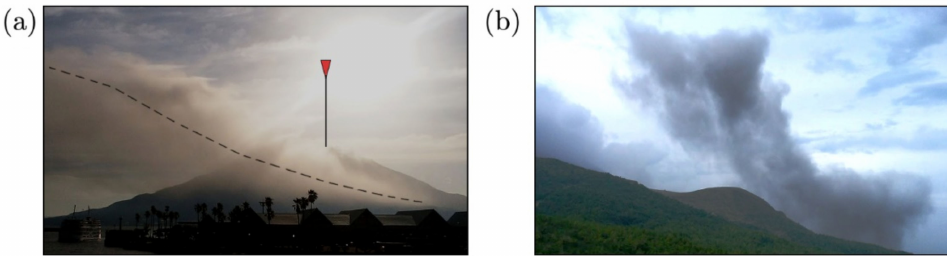
Figure 2. Influence of: ( a ) shear, and ( b ) orographic effects on the dispersal of volcanic ash from Sakurajima volcano. ( a ) Picture taken at 01/10/2017, 0728JST from the Sakurajima ferry terminal in Kagoshima (west of the volcano; 31.57 ◦ N, 130.56 ◦ E), showing dispersal to the north/north–west at approximately 2 km (top of the plume). Wind direction shear caused ash to be dispersed towards the south near the surface (shown with a black dashed line). The location of the crater and height of the eruption (2 km above sea level; asl) shown with a vertical black line and red triangle marker respectively. ( b ) Picture taken at 14/09/2017, 1729JST, from Mt. Haruta (130.63 N, 31.59 E; star marker in Figure 1), showing ash dispersal to the south–west (left to right) over a ridge in the west side of the volcano ( ∼ 31.58 ◦ N, 130.63 ◦